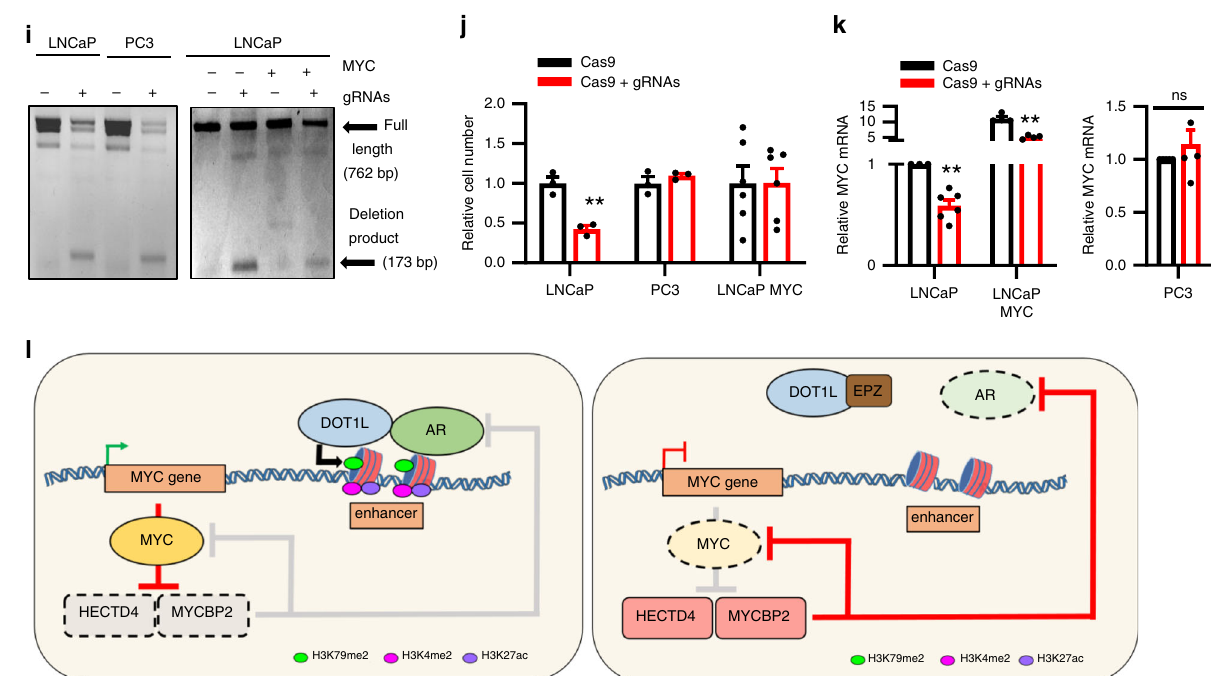
Fig. 7 DOT1L and AR co-regulate MYC expression through a distant enhancer. a ChIP-seq tracks of AR in LNCaP cells treated with R1881 (GSM353644), H3K27ac in LNCaP cells (GSM686937), H3K79me2 in Vehicle and EPZ-treated LNCaP cells (EPZ 1 μ M, 8 days), (top — bottom). b ChIP-seq tracks of AR and H3K27ac in 3 patient samples (GSE120738) at the MYC enhancer. c Enrichment of AR, DOT1L, H3K79me2, H3K27ac, H3K4me2 and RNA Pol II at MYC enhancer in PDX tumors. d AR and H3K79me2 enrichment at MYC enhancer in LNCaP cells treated with Vehicle or DHT for 3 h. e Enrichment of AR, DOT1L, H3K79me2, H3K27ac, H3K4me2 and RNA Pol II at the MYC enhancer in LNCaP cells treated with Vehicle or 1 μ M EPZ for 8 days. f Enrichment of AR, DOT1L, H3K79me2, H3K27ac, H3K4me2 and RNA Pol II at the MYC enhancer in LNCaP cells transduced with EV or AR and treated with Vehicle or 1 μ M EPZ for 8 days. g MYC expression in LNCaP EV or AR cells treated with Vehicle or EPZ for 8 days. h Quantitation of colony formation assays in LNCaP EV or AR cells treated with Vehicle or 1 μ M EPZ for 12 days. i Results of genomic DNA PCR following CRISPR-Cas9-mediated deletion of AR-binding region in LNCaP, PC3, and LNCaP-MYC cells leading to a wild type full length band product and a deletion product. Representative image shown from 3 independent experiments. j Cells per FOV plotted for LNCaP, PC3 and LNCaP MYC ( n = 5) transfected with gRNAs for CRISPR-Cas9-mediated deletion of the AR-binding site at the MYC enhancer after 5 days relative to Cas9 alone cells. k Relative MYC mRNA expression in LNCaP, PC3 ( n = 5), and LNCaP- MYC ( n = 5) transfected with or without gRNAs for CRISPR-Cas9 deletion of MYC enhancer after 3 days. l Graphical summary of DOT1L dependent regulation of MYC expression and its association with AR and MYC protein stability. Dashed lines represent decreased abundance. Gray lines represent inactive pathways. Statistical tests: P value determined by two-tailed t test ( c – h , j , k ). Error bars represent S.E.M. n = 3 biological replicates. * p < 0.05; ** p < 0.01; *** p < 0.001; **** p <